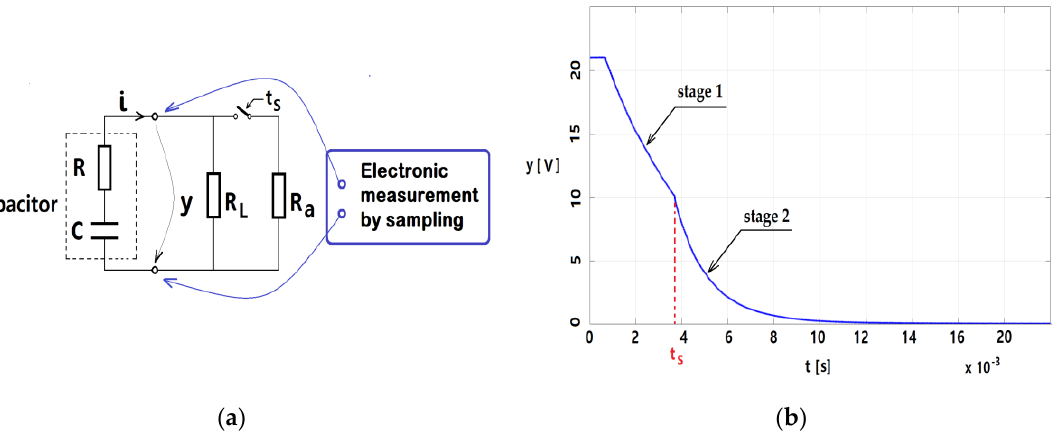
Figure 10. The two-stage discharging of a capacitor: ( a ) experimental scheme; ( b ) voltage variation at capacitor terminals during the